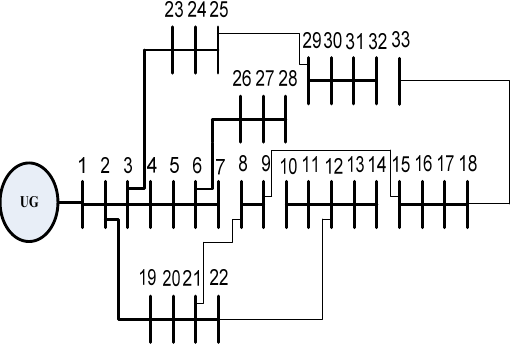
Figure 3. Schematic of IEEE-33 bus reconfigured test system.